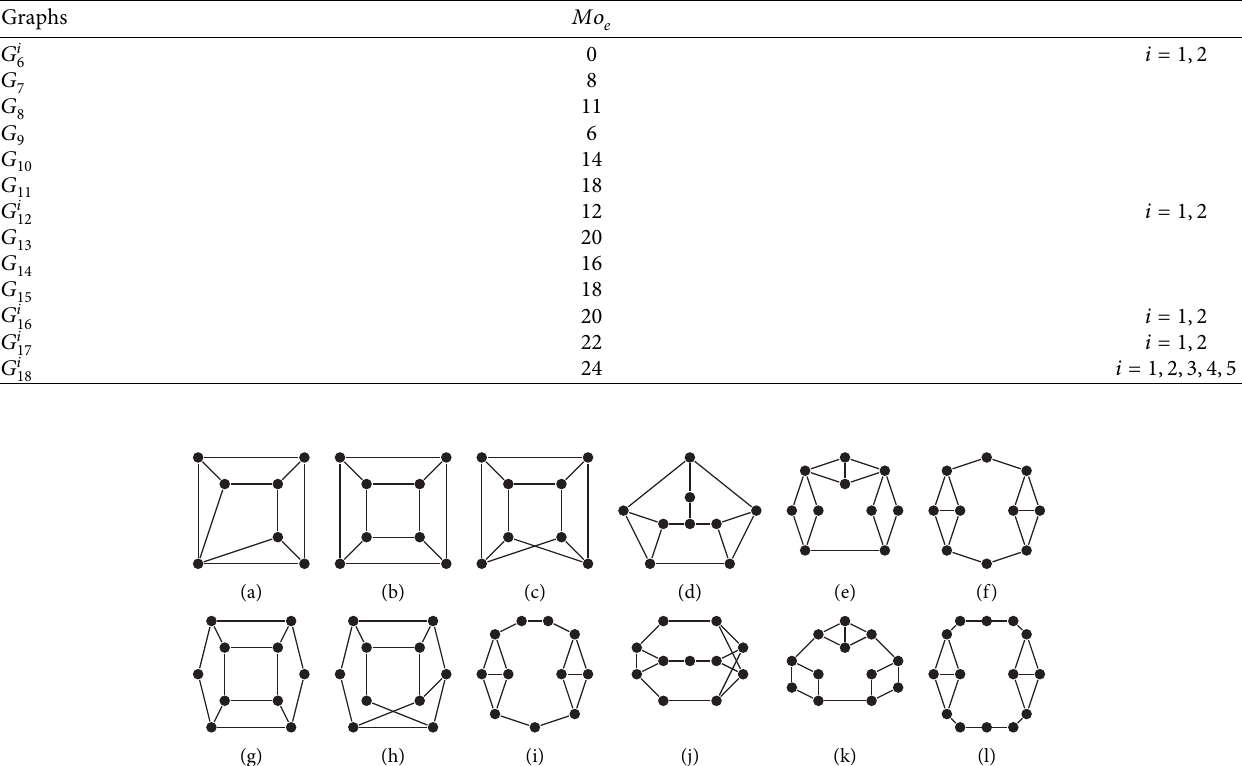
Figure 13: Pentacyclic graphs with minimum edge Mostar index of order n , 7 ≤ n ≤ 13. (a) G